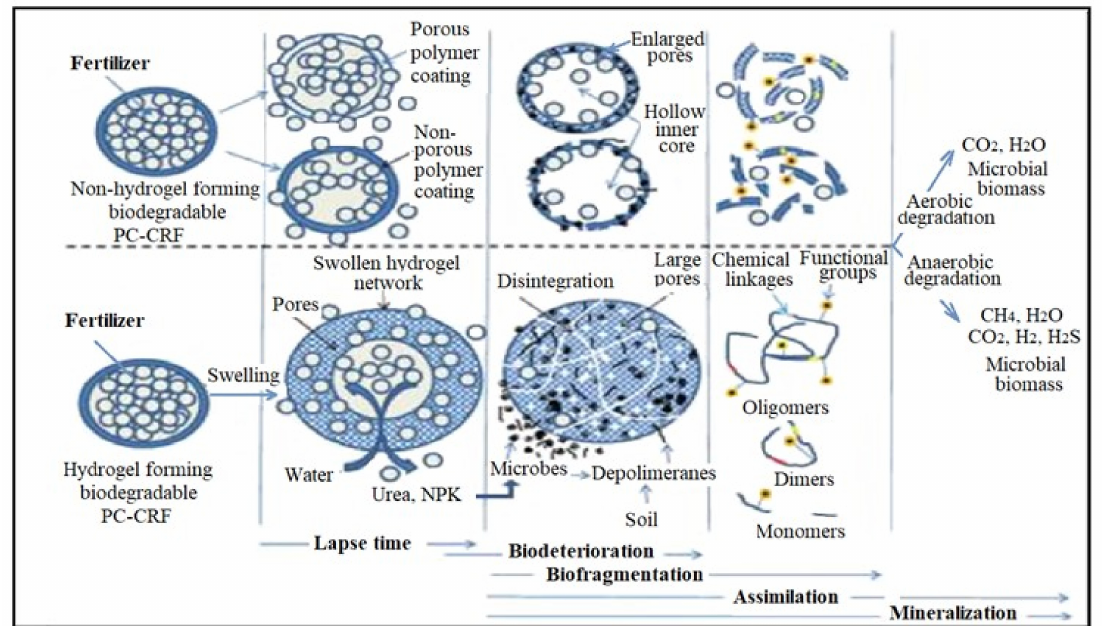
Figure 7. Biodegradation in soils of hydrogel compared with non-hydrogel polymers